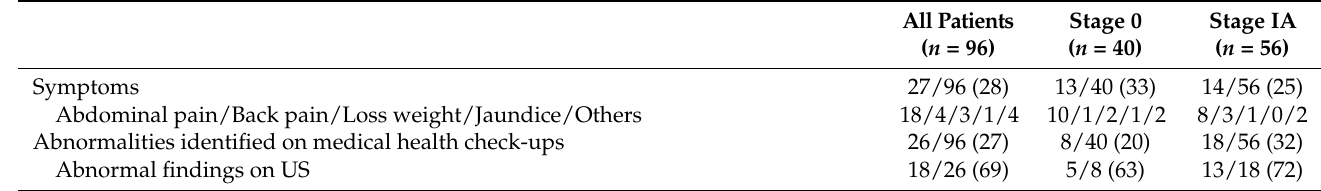
Table 2. Reasons for medical examination in patients with stage 0 and IA PDAC.